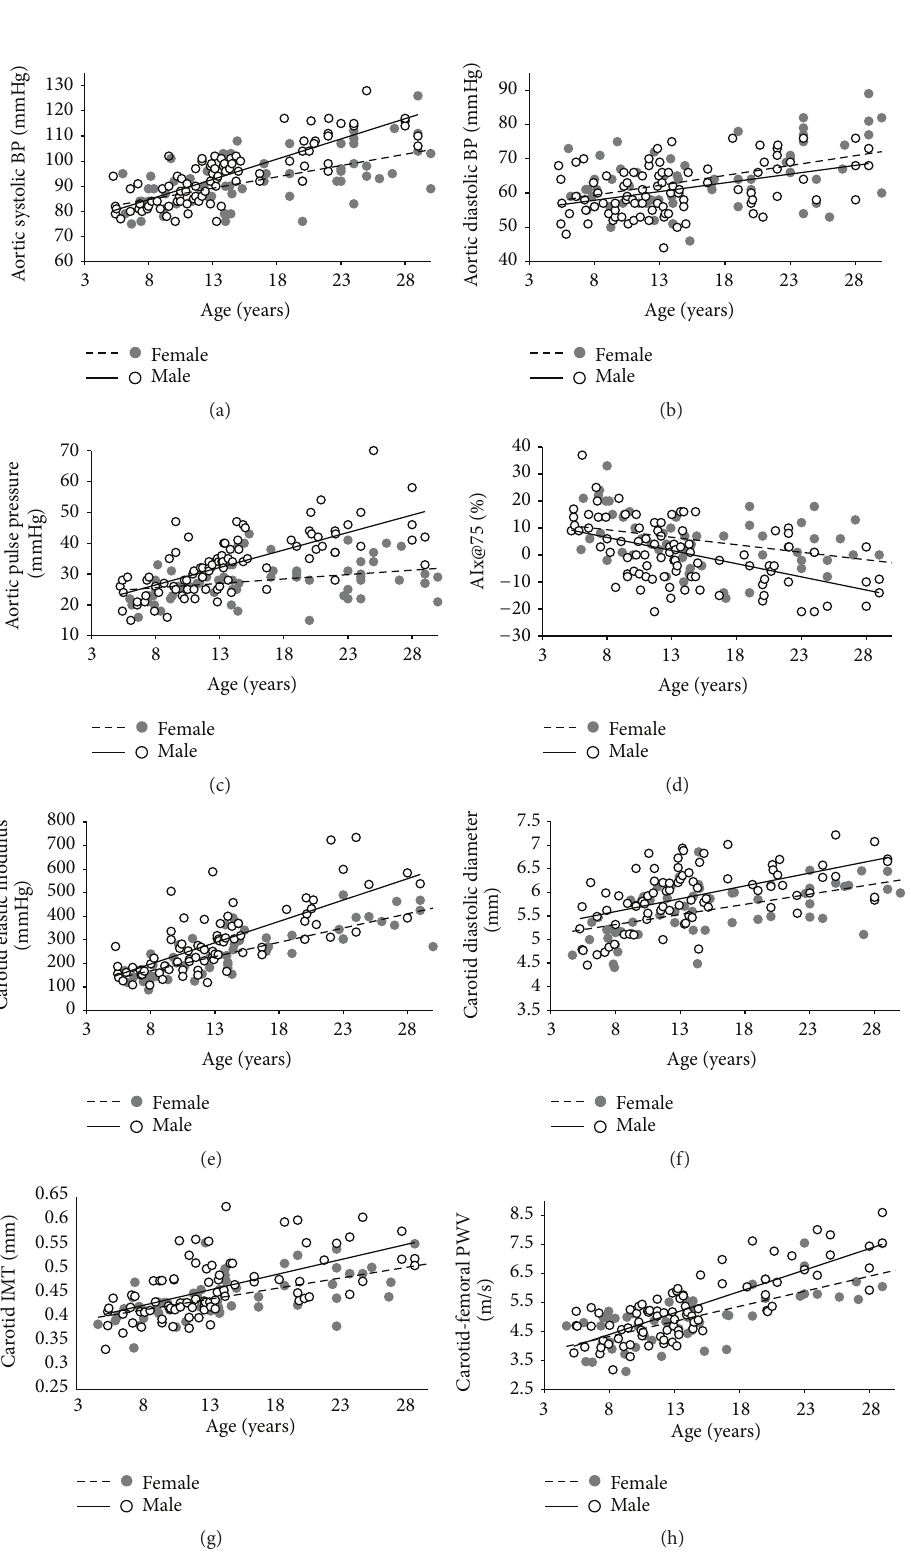
Figure 1: Regression plots for structural and functional arterial parameters. BP, blood pressure; AIx@75, augmentation index; IMT, intima- media thickness; PWV, pulse wave